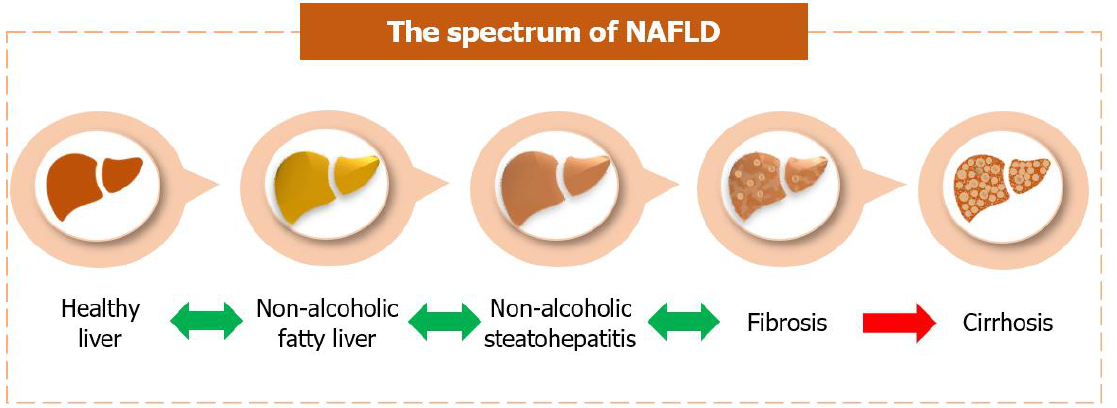
Figure 2. Non-alcoholic fatty liver: There is fat accumulation within hepatocytes at this stage, a process known as hepatic steatosis. Non-alcoholic steatohepatitis: The accumulation of fat in the hepatocytes is accompanied by liver inflammation and hepatocellular ballooning. Fibrosis: Fibrotic scar tissue starts to form in an inflamed liver. According to the NASH Clinical Research Network (CRN) scoring system, fibrosis staging includes stage 0 (no fibrosis), stage 1A (mild perisinusoidal fibrosis), stage 1B (moderate perisinusoidal fibrosis), stage 1C (portal/periportal fibrosis), stage 2 (perisinusoidal and portal/periportal fibrosis), stage 3 (bridging fibrosis), and stage 4 (cirrhosis). Cirrhosis: End-stage liver disease, in which the formation of fibrotic septa bridges together adjacent portal tracts and central veins. There is an increased risk of hepatocellular carcinoma development.